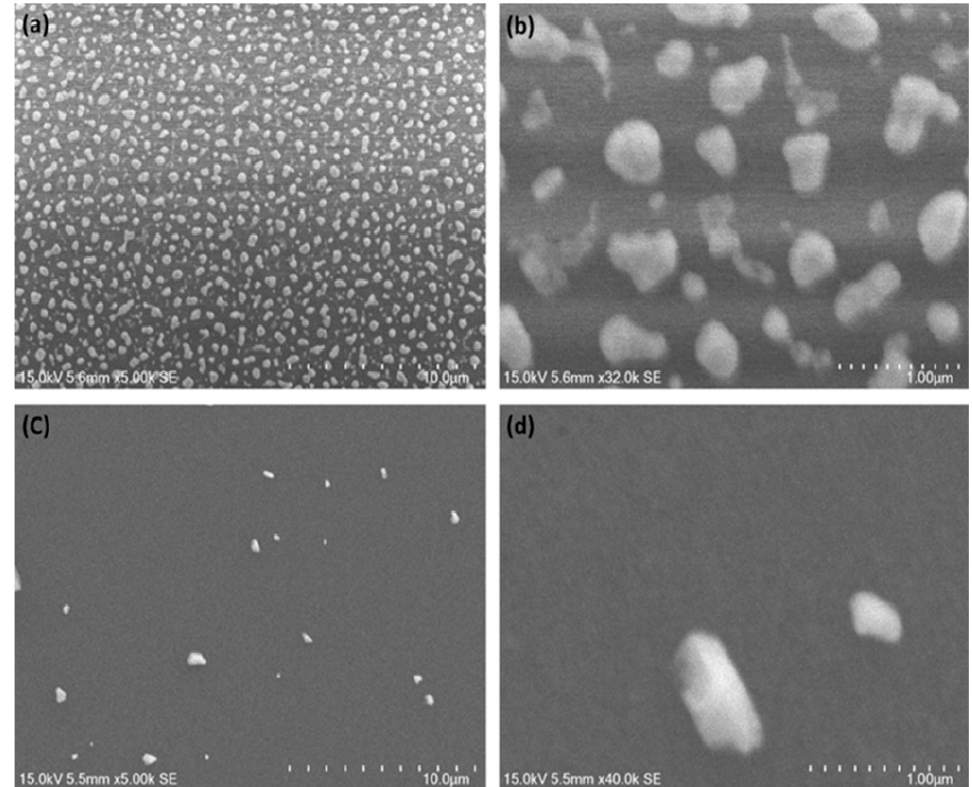
Figure 14. An analysis of the morphology of pristine Ag and pristine Ag with 5% SiC. Following annealing at 350 °C for 1 h, SEM pictures of an Ag thin coating were produced (see a , b ), and an Ag + SiC composite thin coating was recorded following irradiation to the same temperature ( c , d ) . Surface flaws in photos ( c , d ) could be caused by contaminants on the surface or light precipitation. Reprinted with permission from [110]. Copyright 2021 MDPI. Distributed under Creative Commons Attribution-based license (CCBY 4.0.).